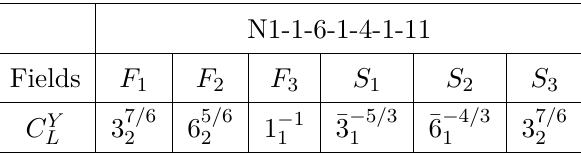
Table 4 . The mediators of the 0 νββ decay model shown in the left panel of figure 10 as well as their transformation properties under the SM gauge group. The quantum numbers are given in the notation C Y , where C refers to the SU(3) C transformation, L refers to the SU(2) L transformation, L and Y stands for U(1) Y